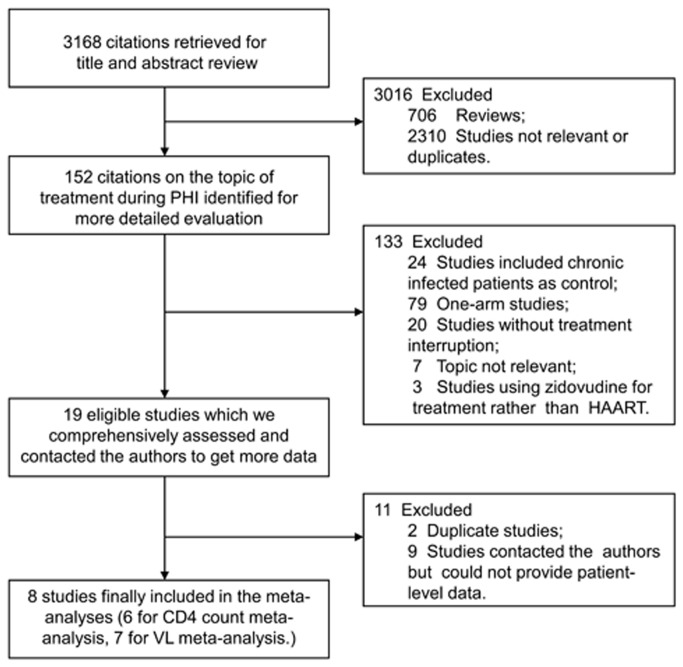
Flow diagram of search, review and data extraction.